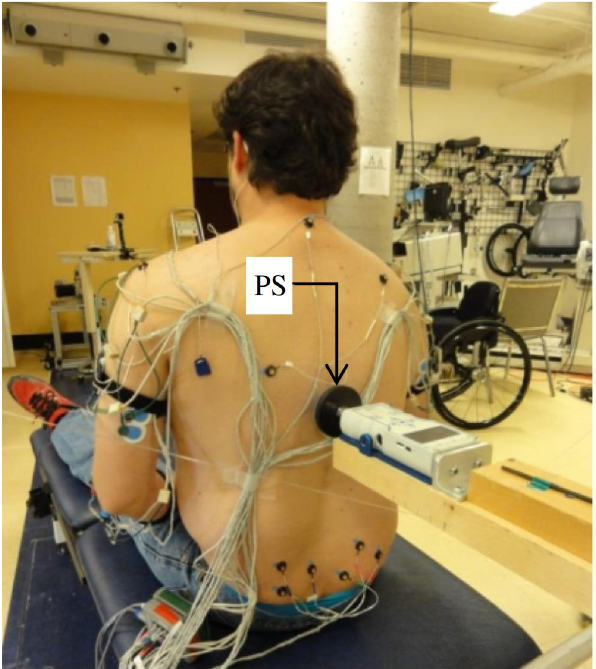
Figure 1. Experimental setup. The perturbation was applied at the level of the third thoracic vertebra.